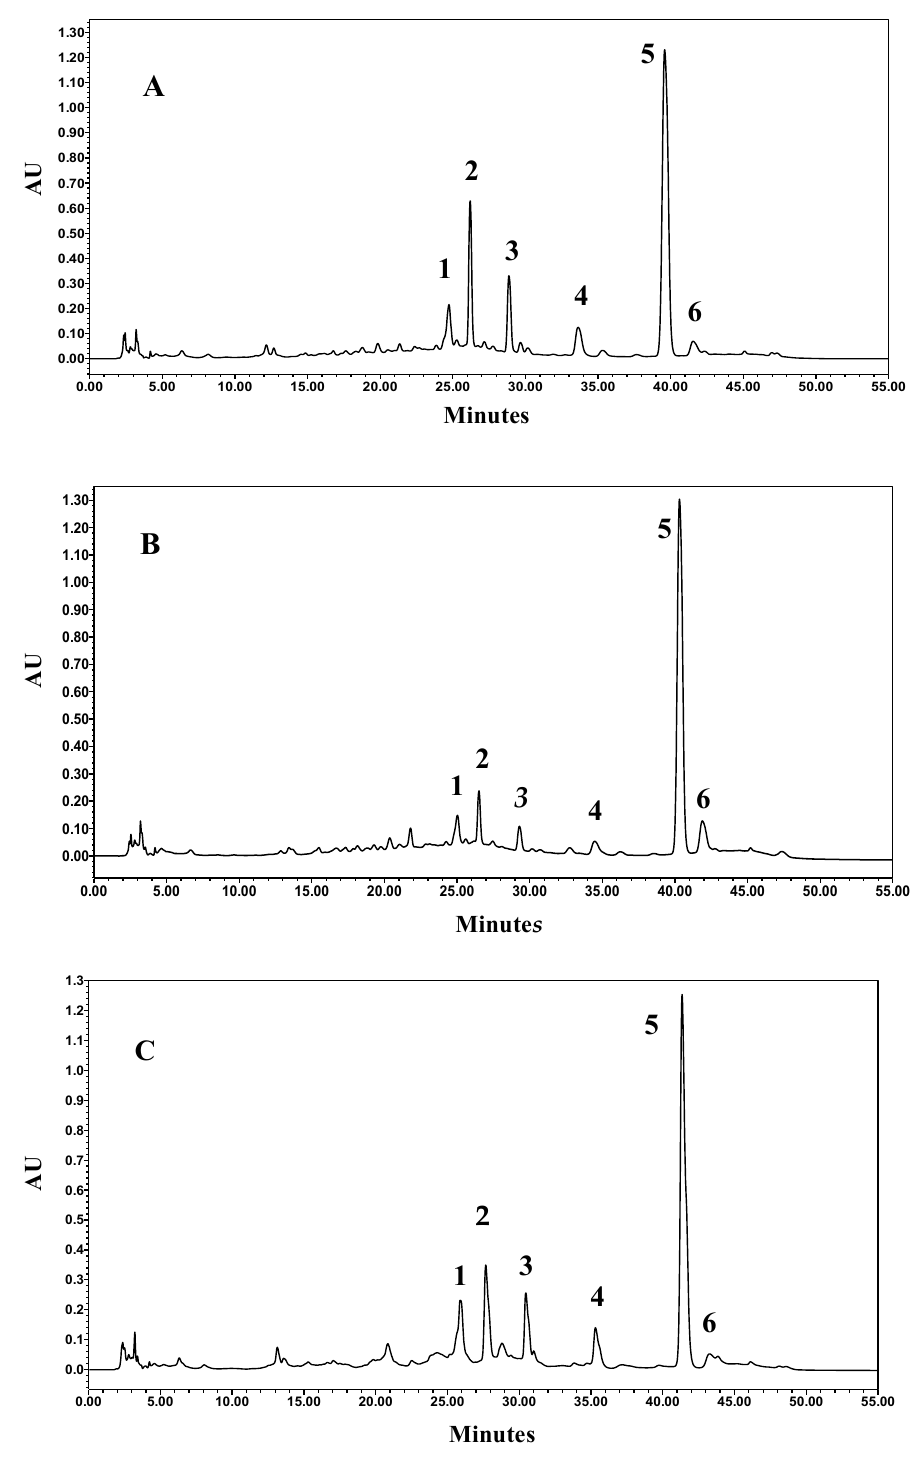
Figure 2. HPLC-DAD (270 nm) chromatograms of the tinctures 019 ( A ), 014 ( B ), and the NST ( C ). For peak naming, see Table